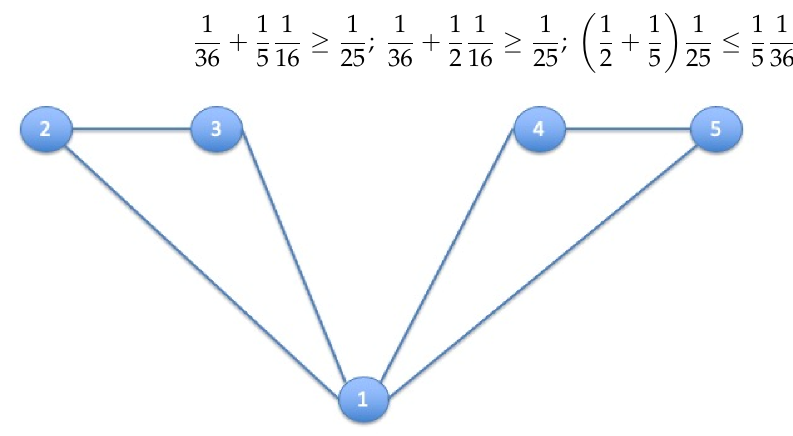
Figure 1. Core-Periphery Network with five